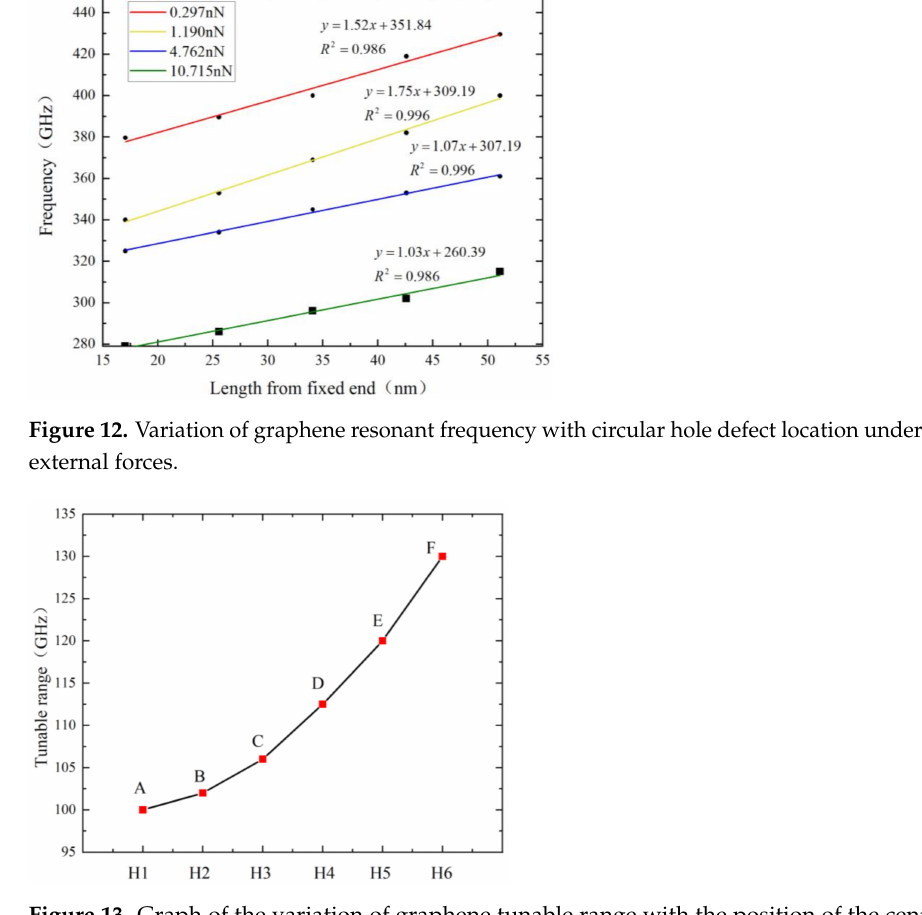
Figure 13. Graph of the variation of graphene tunable range with the position of the center of the hole